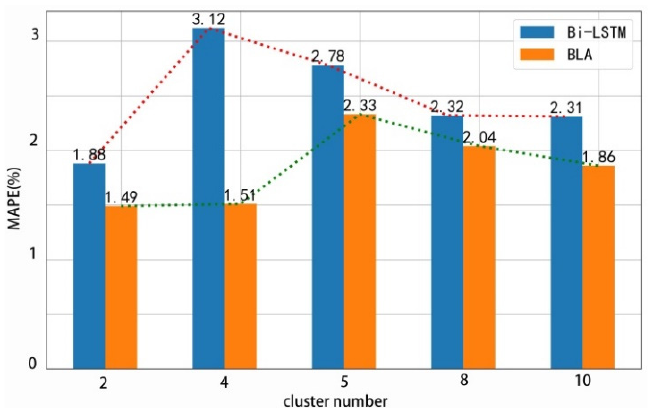
Figure 9. Comparison of MAPE between the Bi-LSTM model and the BLA model under different cluster numbers.